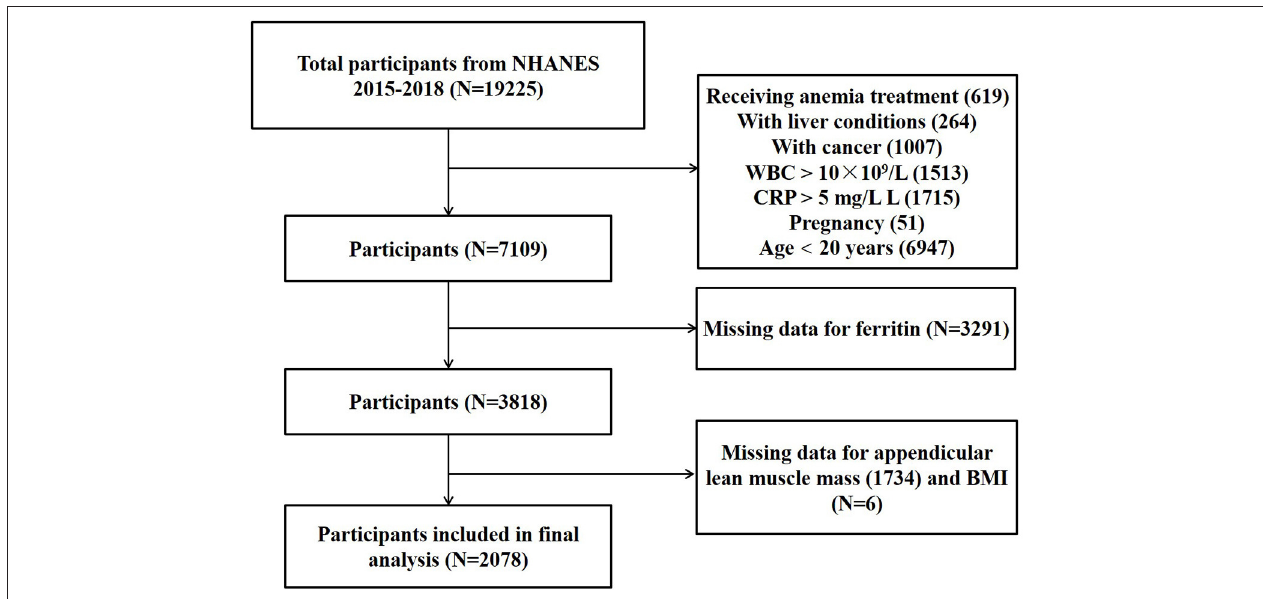
FIGURE 1 | The participant selection